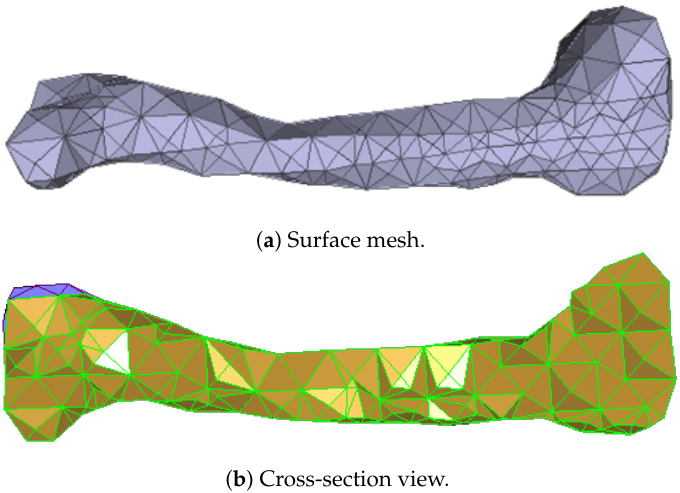
( b ) Cross-section view. Figure 14. Tetrahedral meshes obtained from the input femur model.